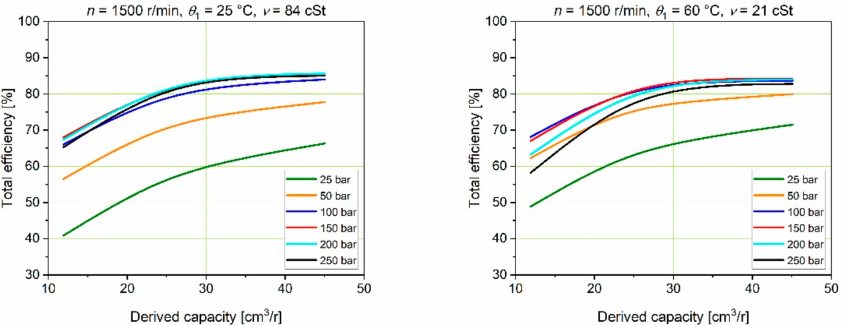
Figure 13. Total efficiency of an axial piston pump as a function of derived capacity with six constant pressures. The four-calculation-point efficiency curves have been smoothed with B-splines.